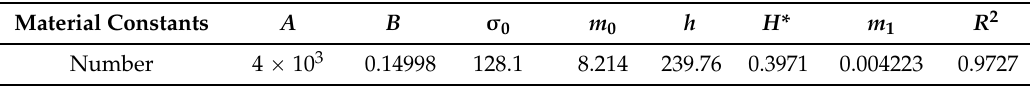
Figure 6. Comparison of fitted values and measured values of 2219 aluminum alloy creep curves at ( a ) 393 K and ( b ) 373 K. Table 4. Creep model parameters of 2219 aluminum alloy ( Q 1 = 96.2 kJ/mol).